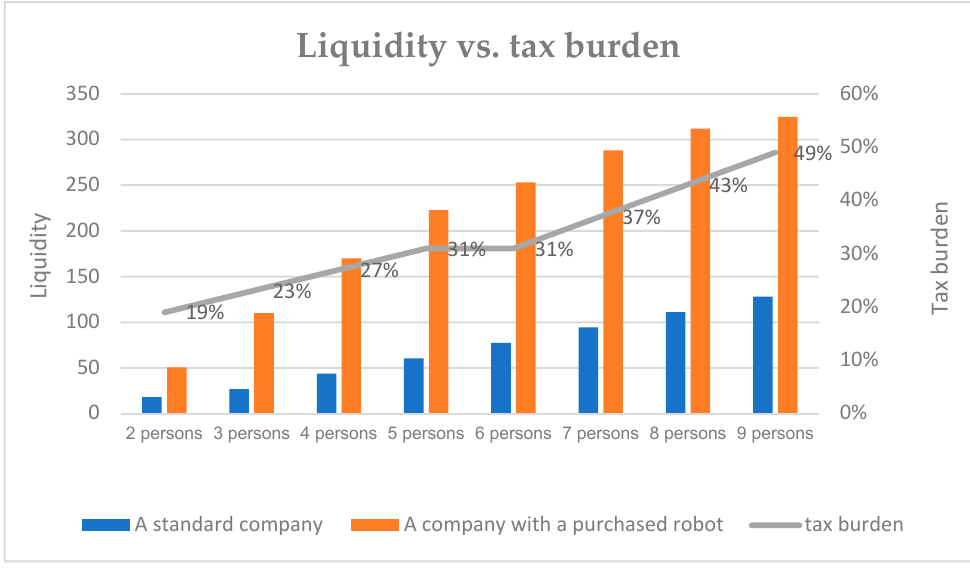
Figure 7. Financial liquidity of business entities employing between 2 and 9 people in the selected varieties, as well as the tax burden for the business entity renting a robot (PLN thousand).